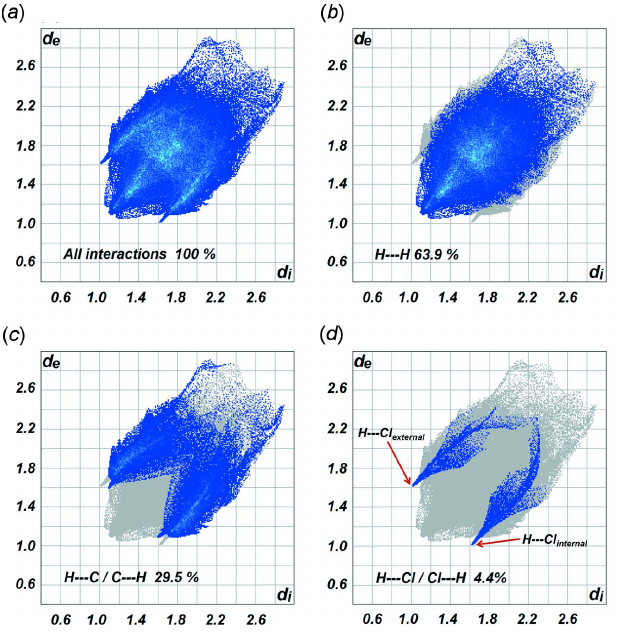
Figure 6 Fingerprint plots corresponding to intermolecular contacts in the crystal: